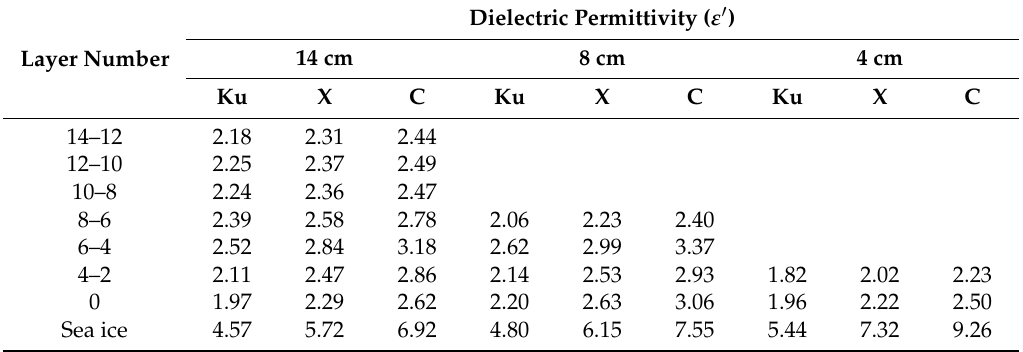
Table 4. Modeled multi-layer snow dielectric permittivity ( ε (cid:48) ) for the 14 cm, 8 cm and 4 cm snow covers on smooth FYI, for Ku-, X- and C-bands. Dielectric Permittivity ( ε (cid:48) ) Layer Number